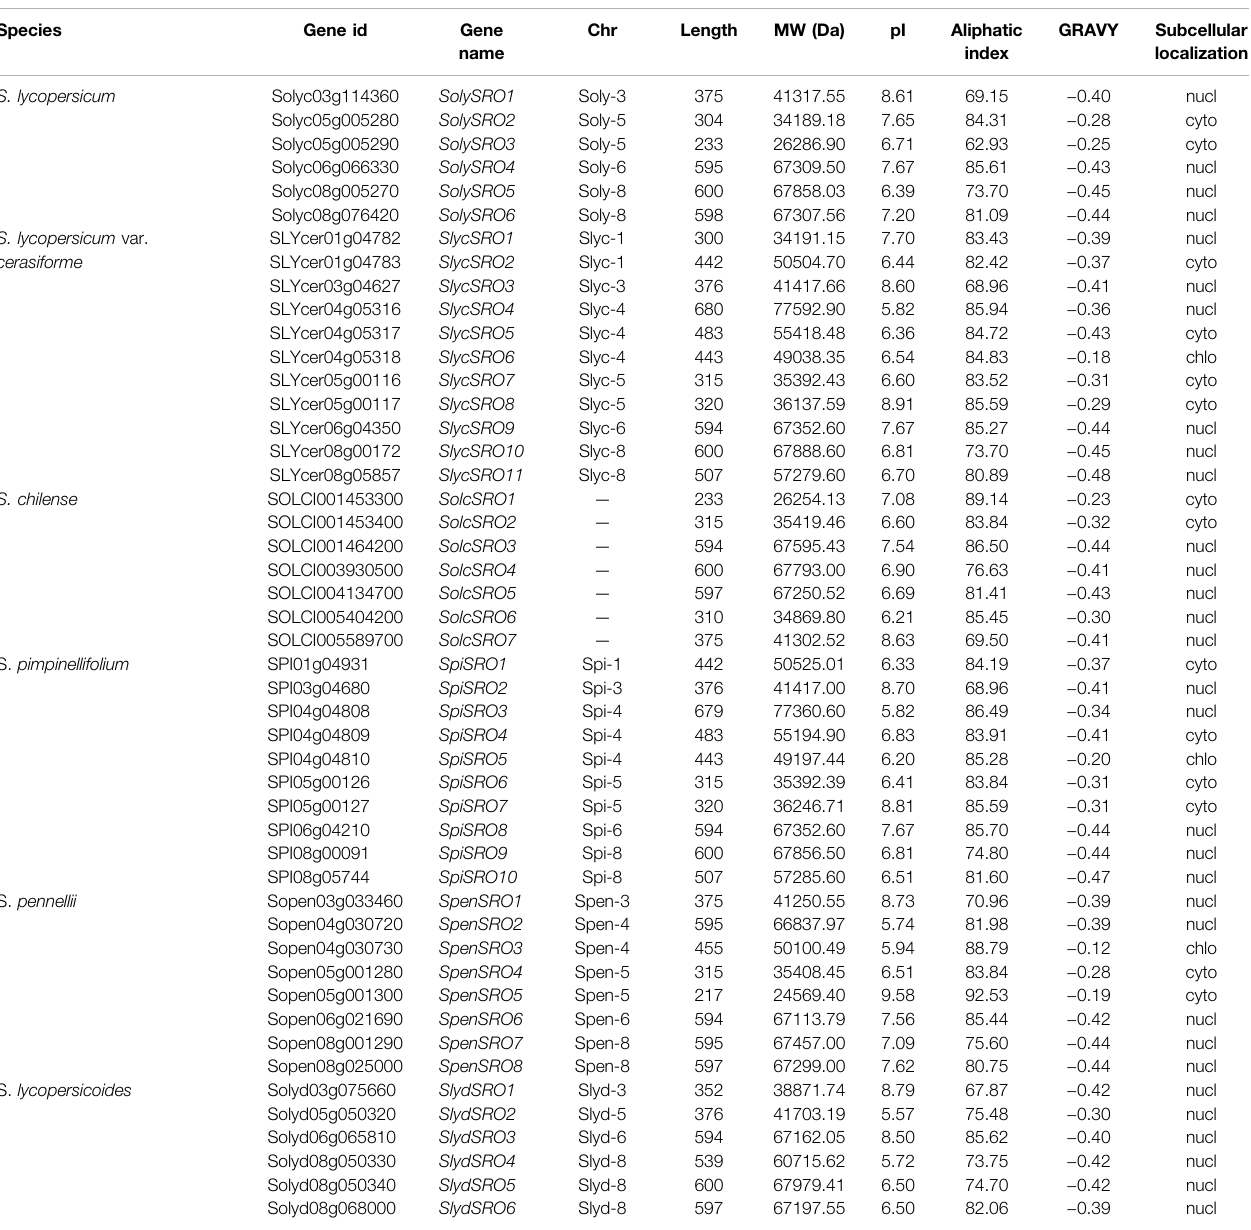
TABLE 1 | Basic information of SRO genes identi fi ed in tomato.